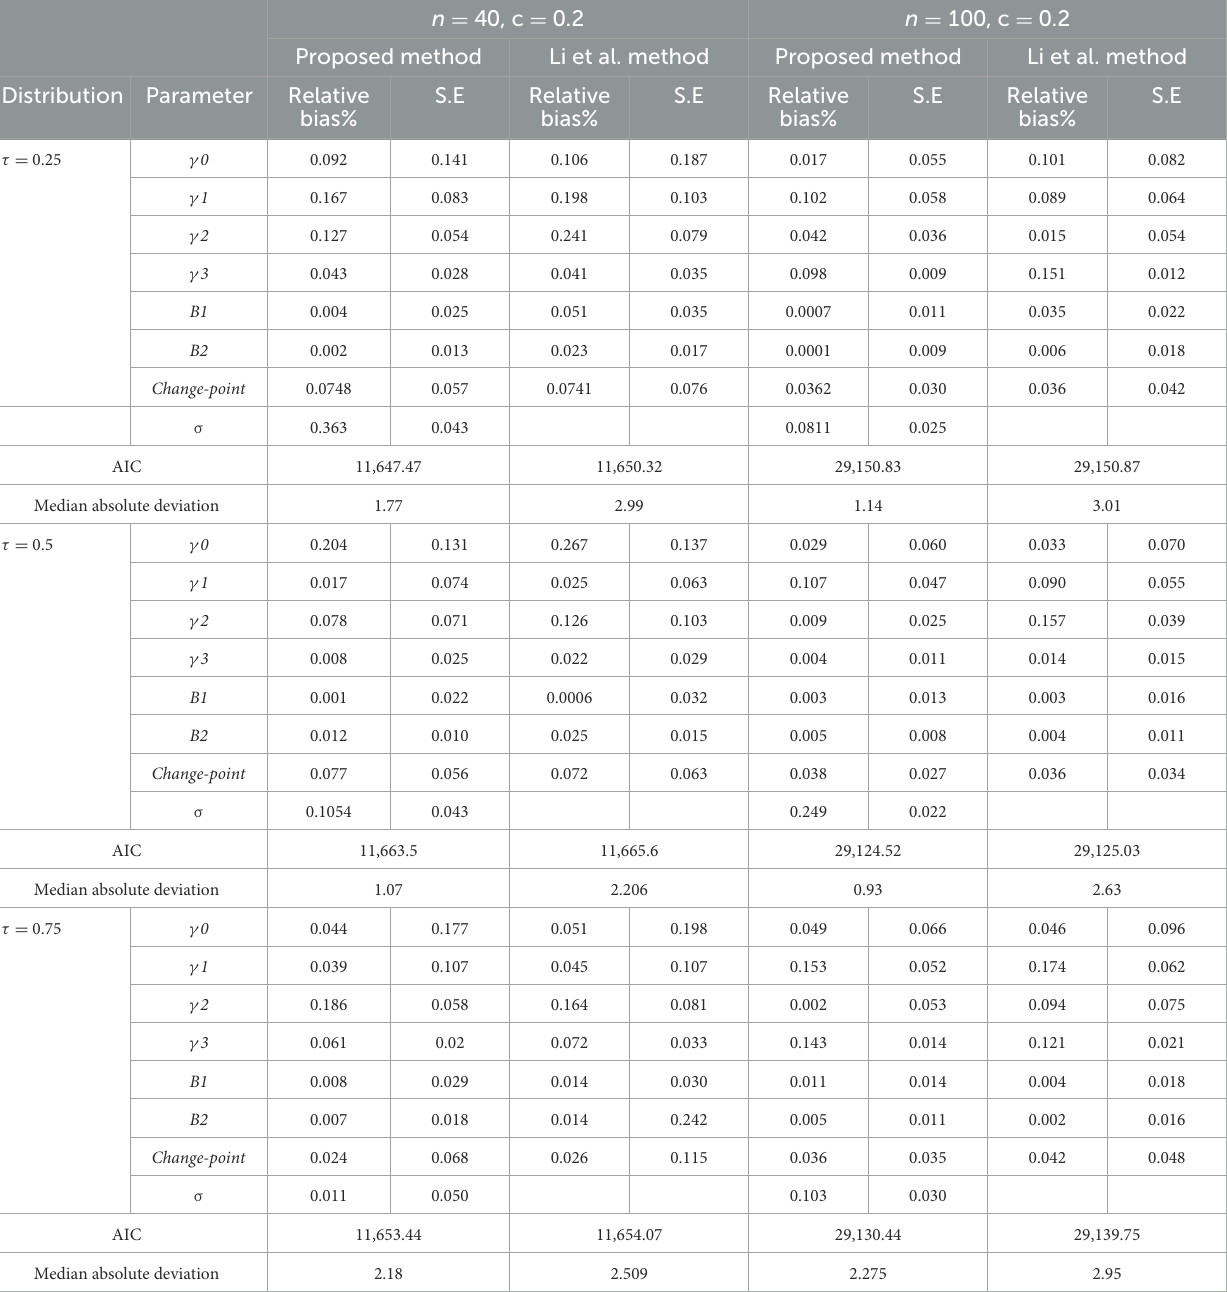
TABLE 2 Simulation results, the standard errors, and the relative bias for different models at n = 40, and 100, ε τ , ij ∼ Lognormal . n = 40, c =